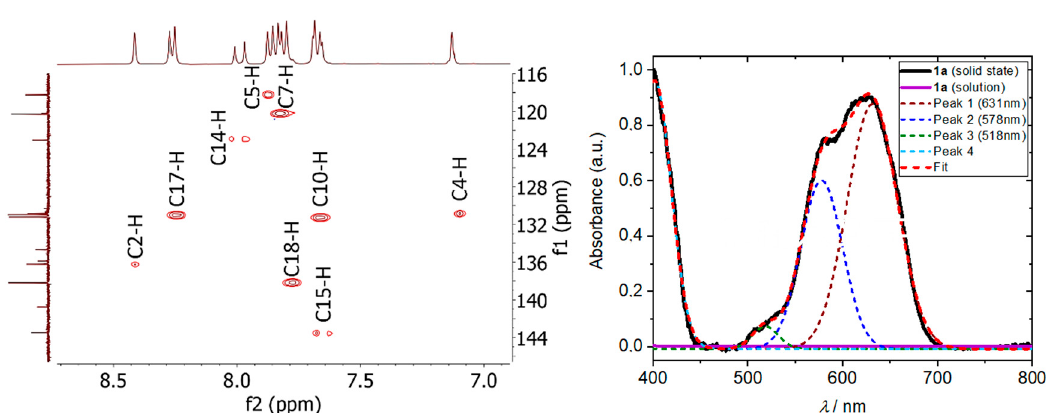
Figure 1. Left —HMCQ NMR spectrum of the ligand 4I-L; DMSO- d 6 solutions. See Scheme 1 for the structural formula and atom numbering scheme. Right —UV-VIS absorption spectrum measured for 1a in the solid state (black line) and methanolic solution (violet line) in the range of 400–800 nm. Fit to four Gaussian primitives shown as dashed lines with peak maxima listed in the